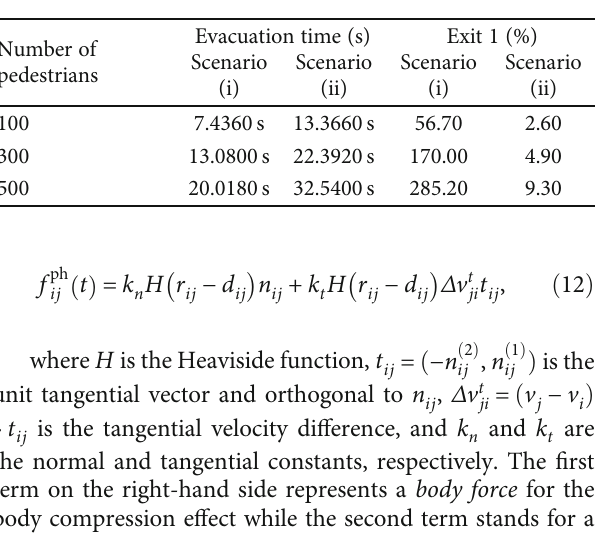
Table 2: Average evacuation time and percentage of pedestrians who move out through Exit 1. The source is in the middle of the room in scenario (i) and in front of Exit 1 in scenario